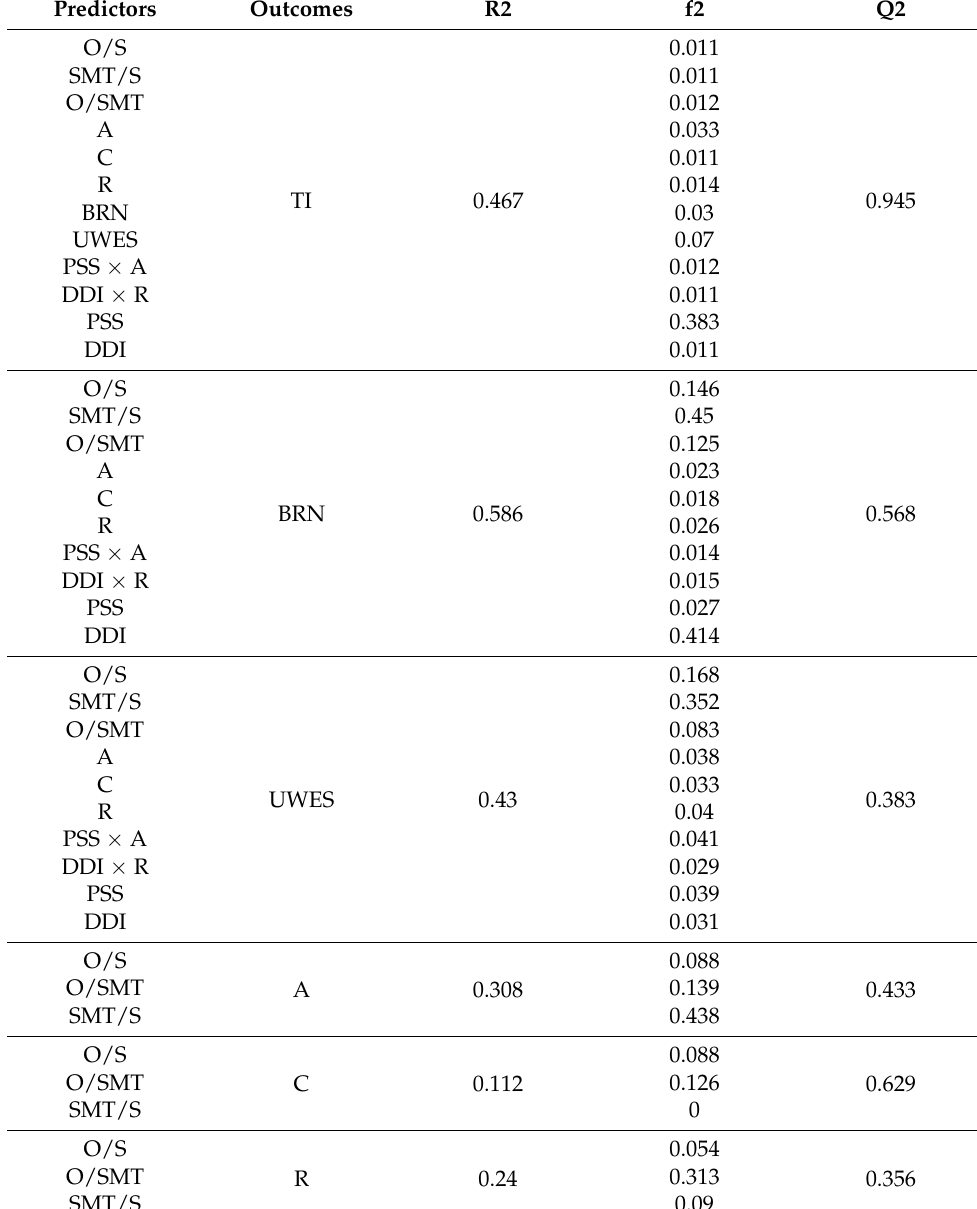
Table A7. Explanatory and Predictive Power of the